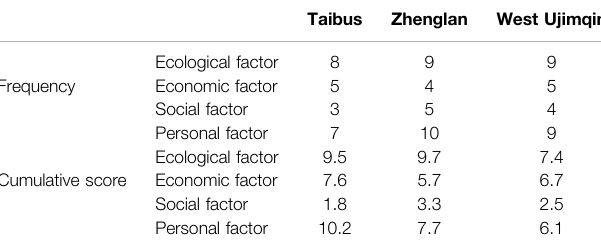
TABLE 4 | Degree of in fl uence scores of the different food consumption impact factors and the frequency mentioned by